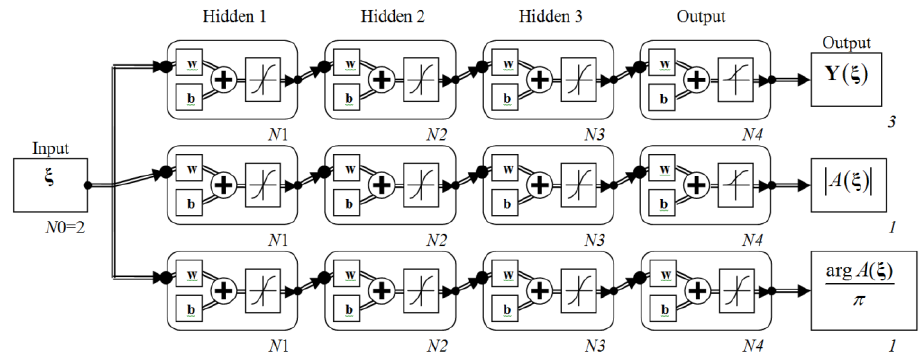
Fig. 1. The structure of